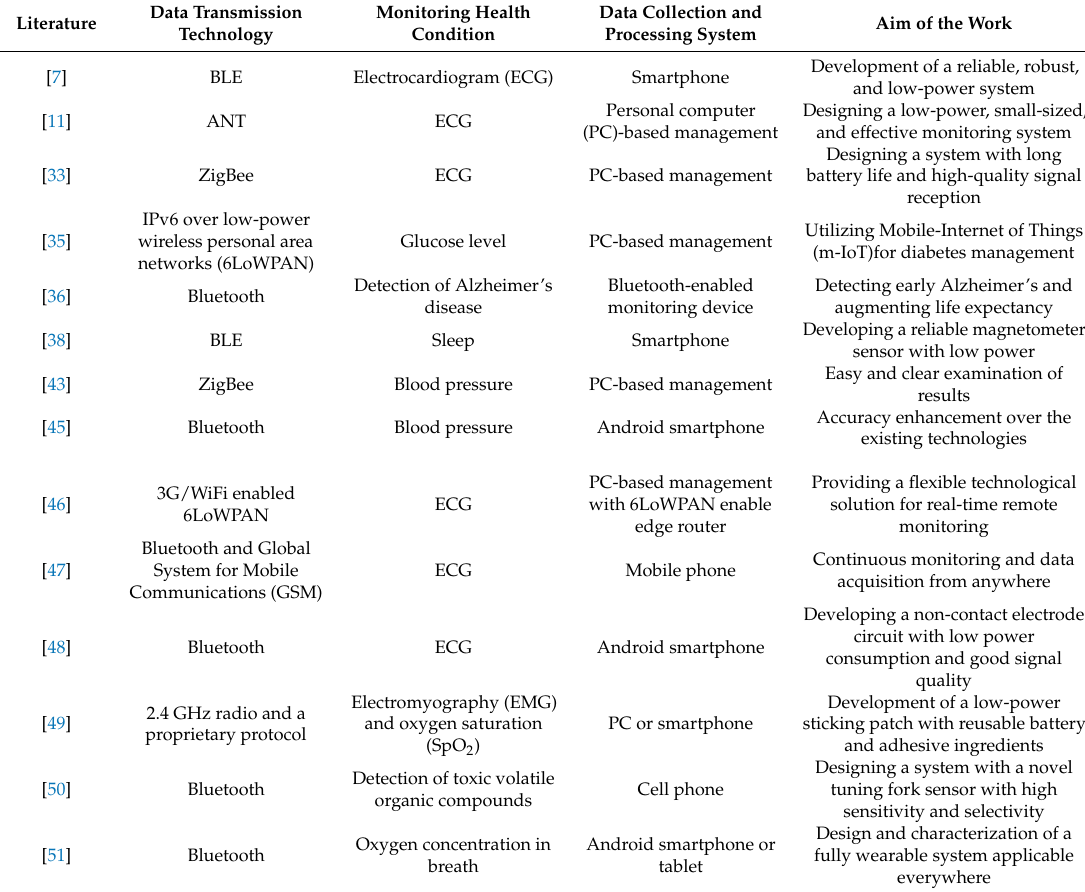
Table 2. Summary of health monitoring systems developed based on the